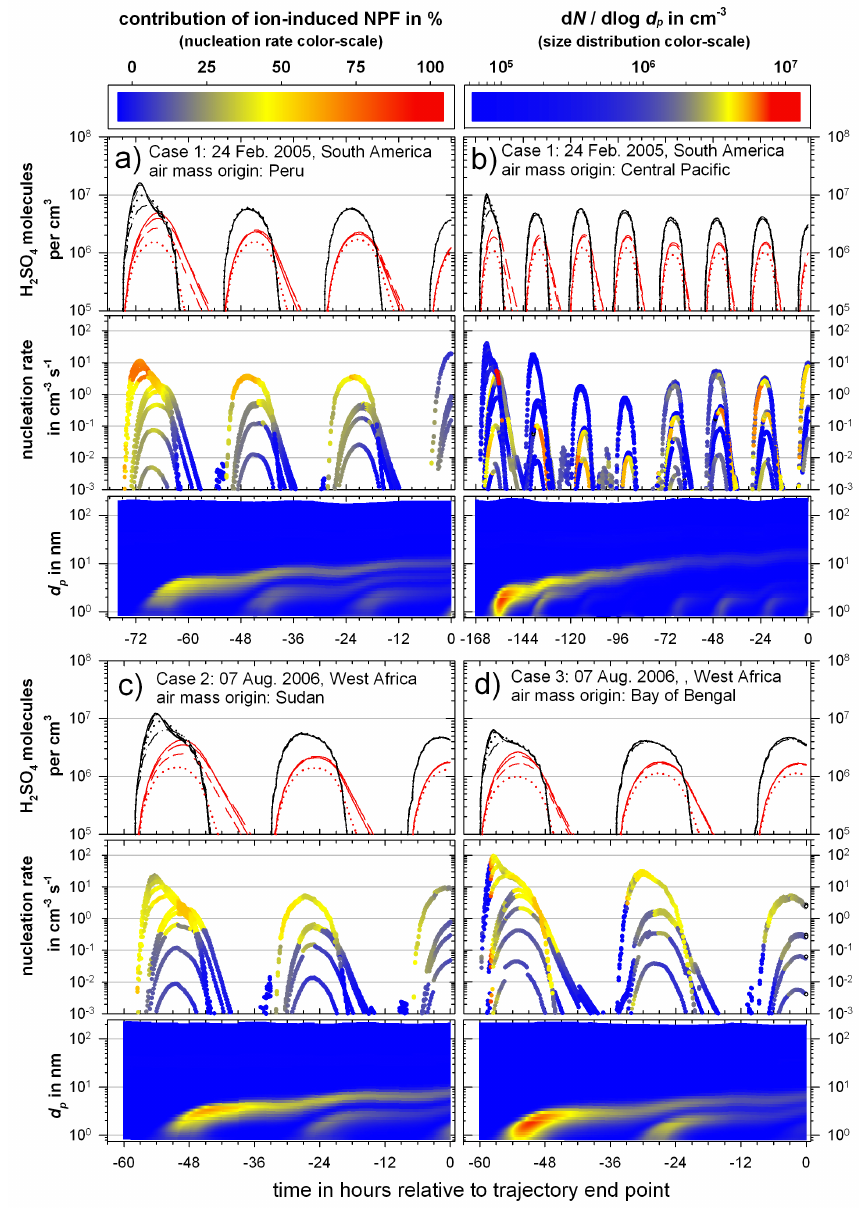
Fig. 8. H 2 SO 4 concentration (top panels), nucleation rate (mid panels) and particles size distributions (bottom panels) for the Cases 1 through 4 simulated with MAIA (Fig. 7a–d). Color-coding and line style of the H 2 SO 4 concentration curves follow the legend in Fig. 7. The nucleation rate is color-coded according to the fractional contribution of ion-induced NPF. Nucleation bursts occur with a 24-h periodicity, in correlation with the solar zenith angle, which determines OH concentrations and H 2 SO 4 production from the reaction SO 2 +OH. Particle size distributions for each Case are displayed for a single simulation only (initialized with 50pptv of SO 2 and 1.0µm 2 cm − 3 aerosol surface